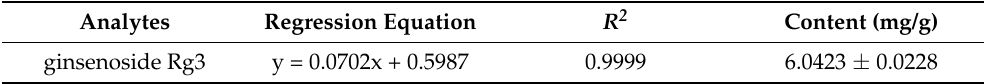
Table 1. Regression data and content of ginsenoside Rg3 in RGE .